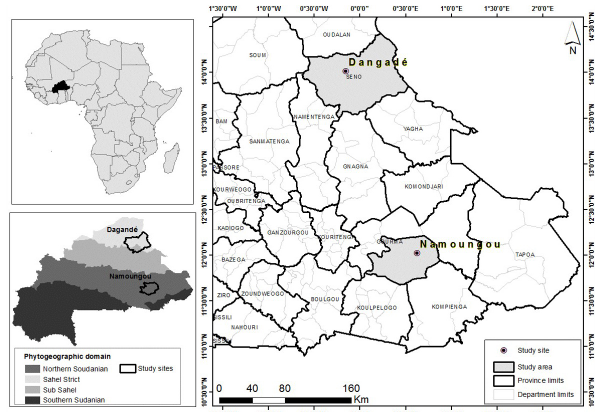
Figure 1. Phytogeographic domains and geographic locations of the experimental